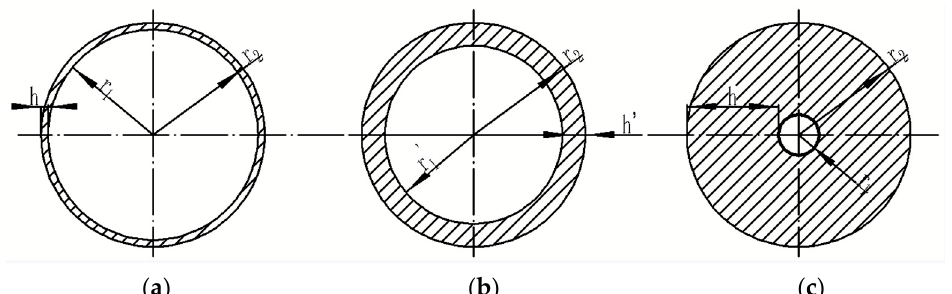
Figure 11. Relationship between wall thickness and inner and outer diameters; ( a ) ultra–thin wall thickness ( b ) normal wall thickness ( c ) ultra–thick wall thickness.